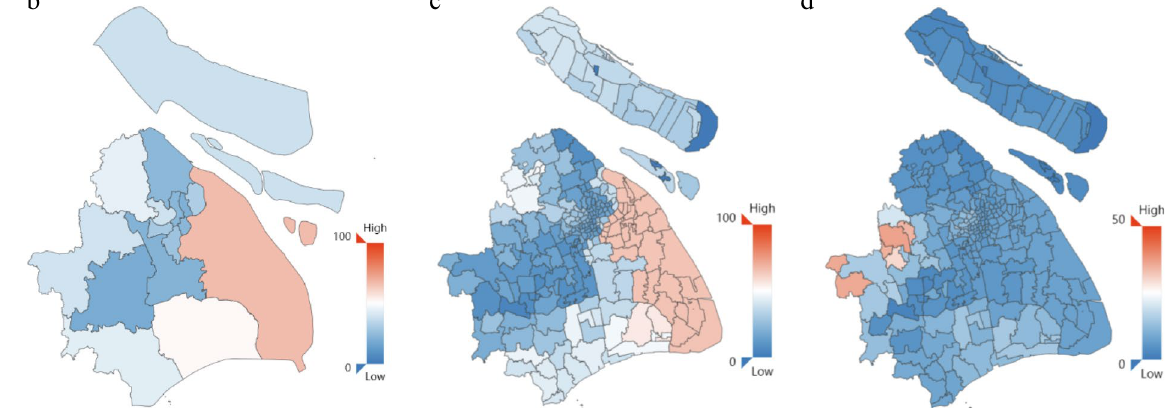
Figure 4. COVID-19 transmission risks in Shanghai. ( a ) Two kinds of COVID-19 transmission risks in 16 districts of Shanghai. ( b ) Map of Shanghai total transmission risk in district level. Baoshan, Jiading and Qingpu locate in the west of Shanghai, bordering Jiangsu Province; while Qingpu and Jinshan border on Zhejiang Province. According to Baidu Migration Index, Jiangsu and Zhejiang are the two major provinces of immigration to Shanghai from January 22 to February 4, 2020 (see more details in Supplementary Information). ( c ) Map of street-level transmission risk due to epidemic hot zones people inflow. ( d ) Map of street-level transmission risk due to close contacts within